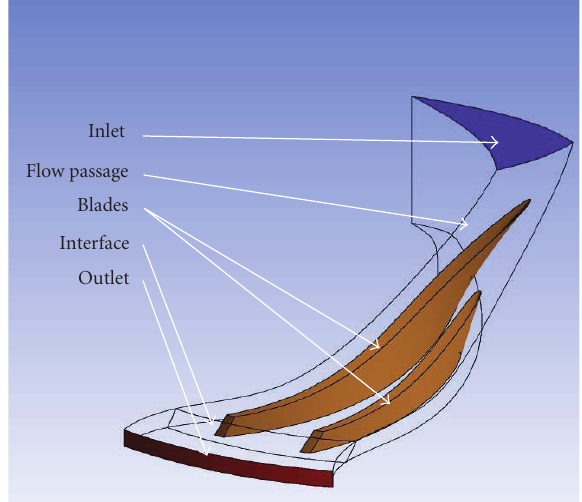
Figure 1: Schematic of a single passage of a centrifugal